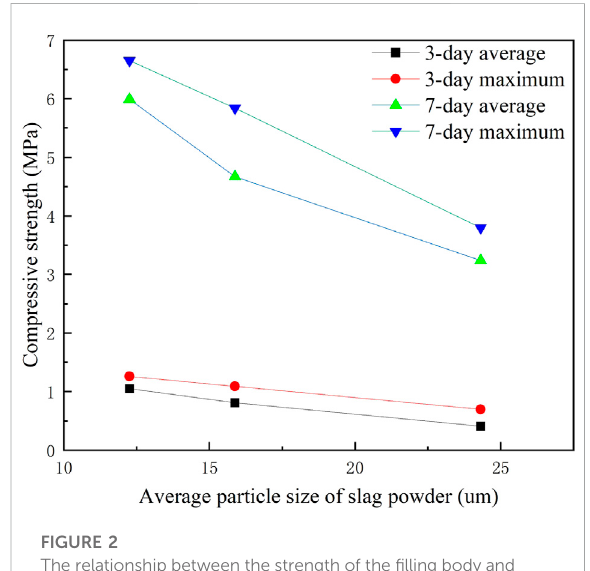
FIGURE 2 The relationship between the strength of the fi lling body and the average particle size of the